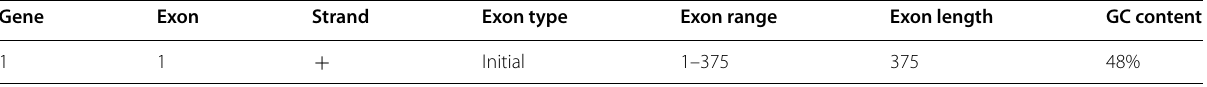
Table 2 Prediction of exon, exon position, exon range, exon length, and GC content by GeneWise tool Gene